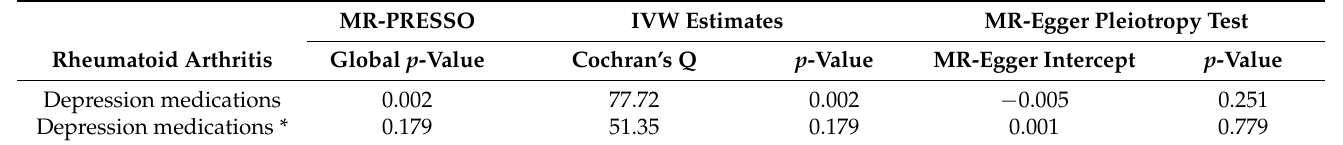
Figure 2. The results of Mendelian randomization for the associations of genetically predicted rheumatoid arthritis and rheumatoid arthritis * (after removing outliers) with depression medications. Table 2. The results of sensitivity analyses using multiple